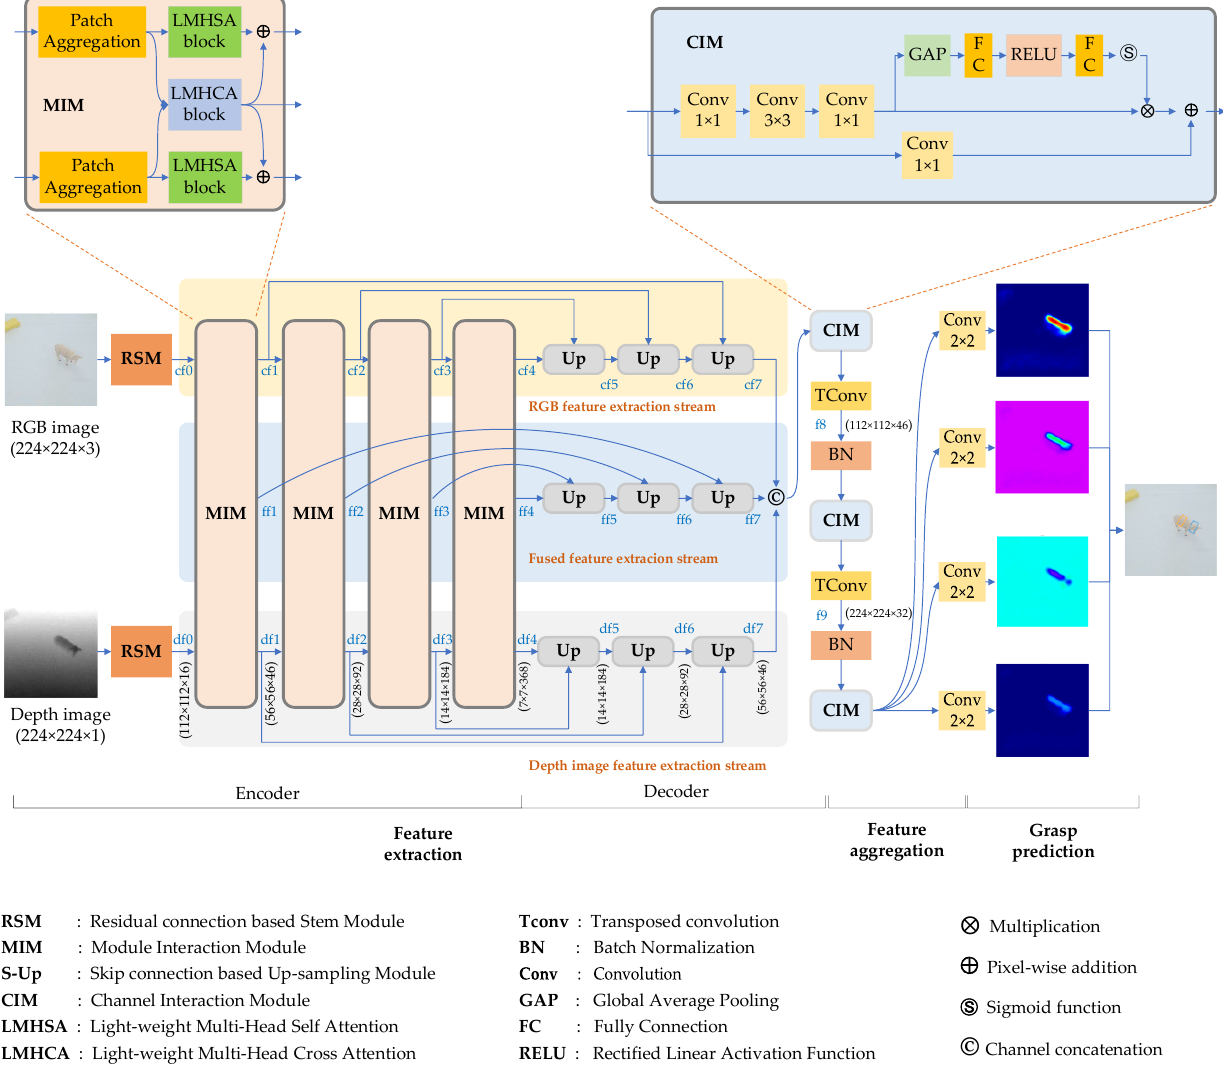
Figure 1. Bilateral cross-modal fusion network architecture.